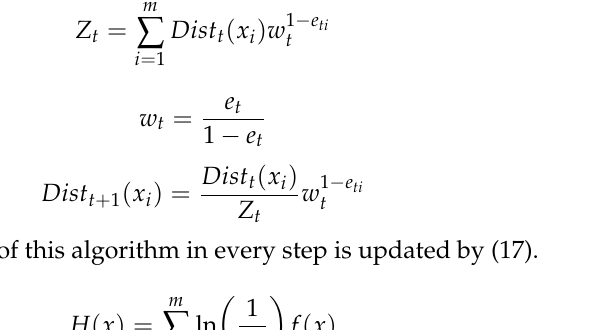
Figure 6. Voltage prediction on pack and cells in DST condition . 4. Results and Discussions 4.1. Data Sources In this study, we use the actual vehicle data from the cloud platform to prove the accuracy of the proposed algorithm and the ISC detection performance of specific burning vehicles. The test data that were obtained from the actual vehicles were from ones that were driven in China, and the NMC battery pack of each vehicle contains 344 cells ar- ranged in the configuration of 86S4P. Since four cells in parallel were equipped with one voltage sensor, every four cells in parallel were assumed to be a cell module in this paper. The data of five vehicles were mainly selected, including the data of three vehicles in nor- mal operation and two vehicles that were reported as faulty vehicles, which was con- firmed by a maintenance check. The data were collected by the sensor system of the vehi- cle BMS and uploaded at sampling intervals of 30s. The upload process of actual data was not continuous and only occurred when the vehicle BMS was online. We deployed a data cleaning process that was related to the quality of the online data, and its format during the signal deficiency was preprocessing. The time periods of the generation of the inter- cepted data was mainly conducted in 2021. In the following work, the start time of the intercepting data was recorded as “0” time, and the data were spliced at intervals of 30s.